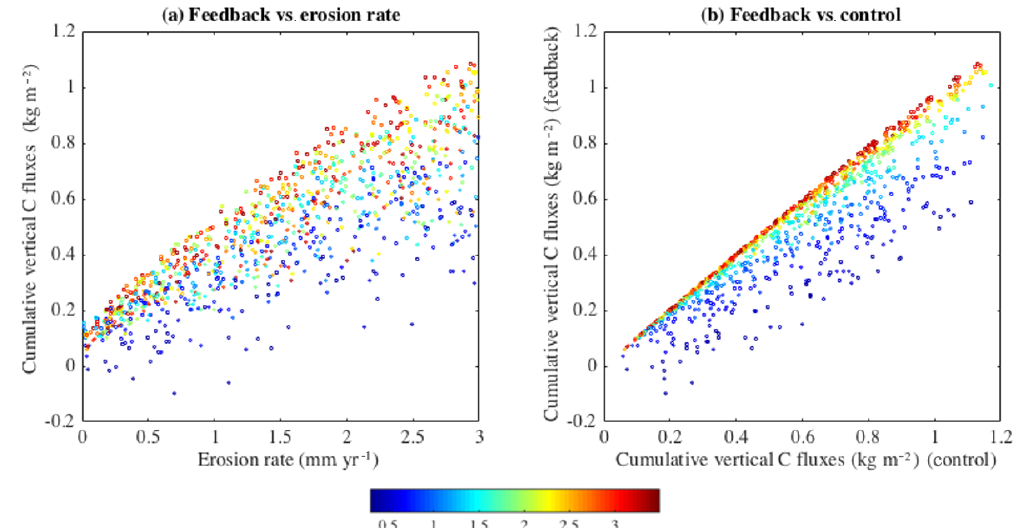
Figure 6. (a) Cumulative vertical C fluxes (kgCm − 2 ) after 200 years for the dataset including the effect of erosion on productivity (FB) as a function of erosion rate (mmyr − 1 ). (b) Cumulative vertical C fluxes (kgCm − 2 ) for FB against the cumulative vertical C fluxes (kgCm − 2 ) for CTL, for all erosion rates. Positive cumulative vertical fluxes represent a net uptake into soils, while negative values represent a net loss to the atmosphere. The colour scale represents the exponent B value, where B< 0 . 9 a concave relationship and B> 1 . 1 represents a convex, threshold relationship. When 0 . 9 <B< 1 . 1, productivity decreases linearly with soil